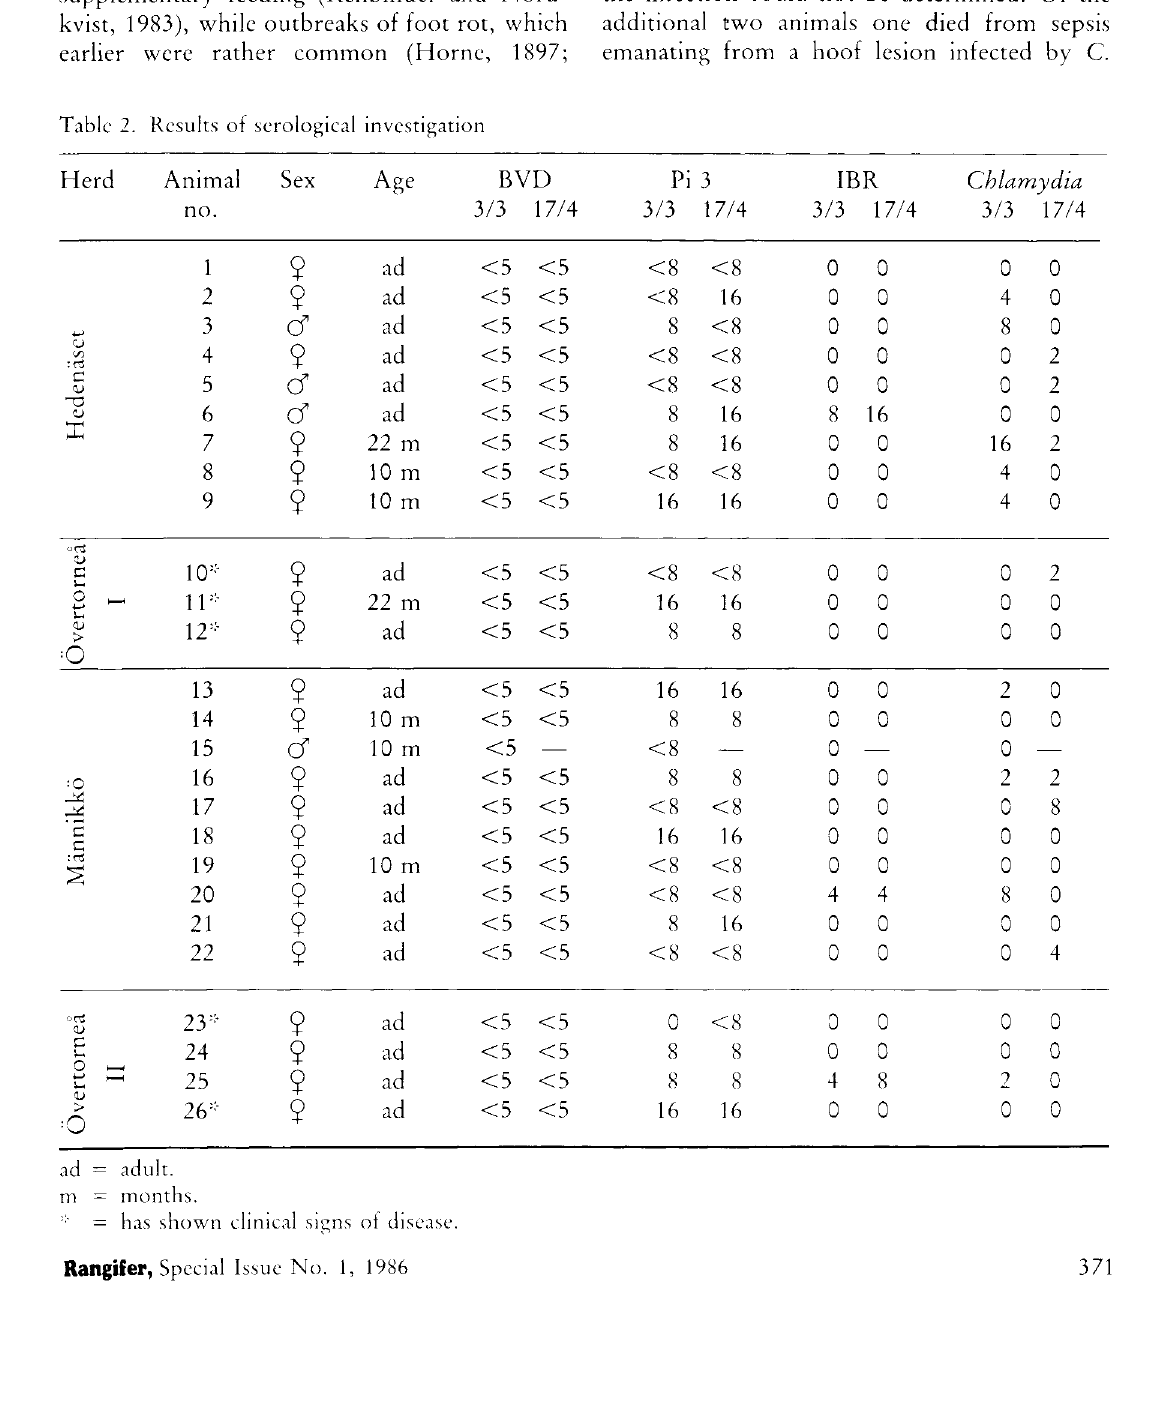
Table 2. Results of serological investigation Herd